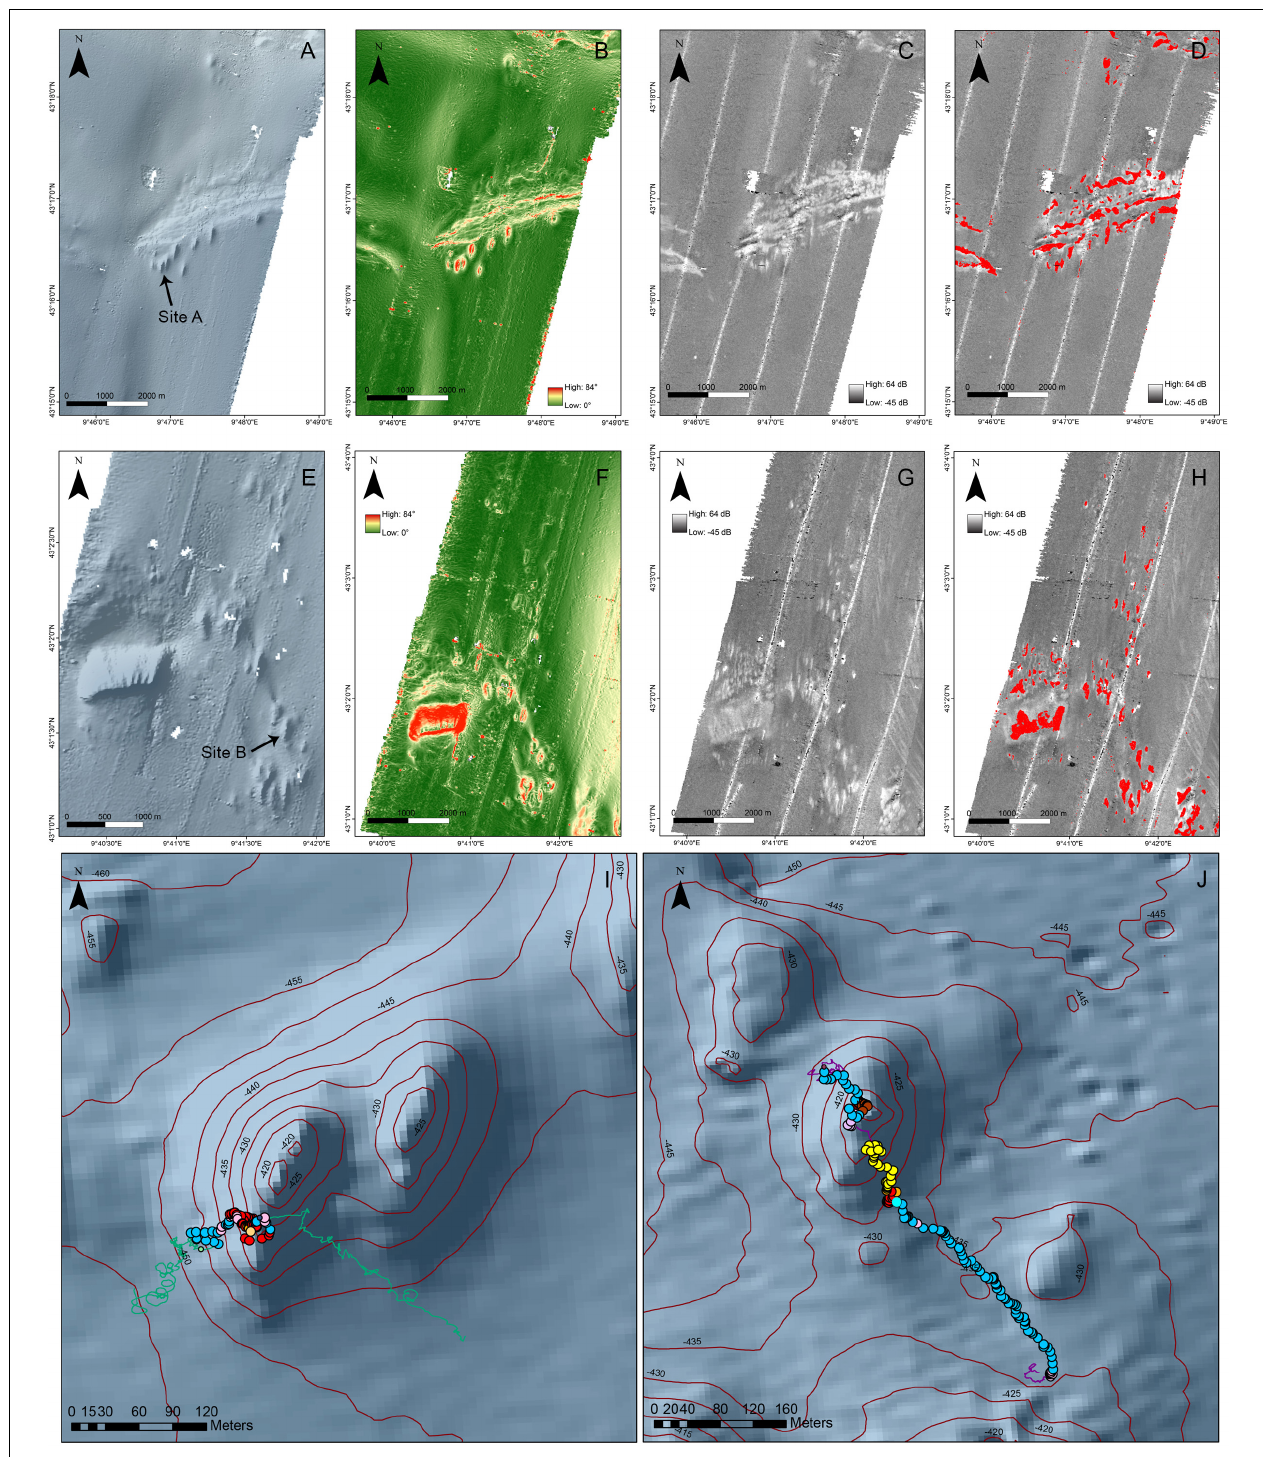
FIGURE 2 | Site A (A–D) and Site B (E–H) morphobathymetrical and backscatter data. Panels (A,E) represent the morphobathymetric map of the two coral mound areas; (B,F) slope map of the study areas, calculated from the digital terrain model (DTM), clearly showing the difference between the side slope of the coral mounds reaching a maximum value of 39 ◦ and the regional surrounding slope about 1 ◦ –8 ◦ ; (C,G) backscatter photomosaic of the surveyed area and (D,H) automatic selection of all features with backscatter intensity > 15 dB. (I,J) Habitat mapping performed on Site A remotely operated vehicle (ROV) survey and Site B, respectively; blue dots represent muddy sediments, red dots show living Madrepora oculata , yellow dots indicate the presence of coral rubble, and pink dots refer to cold-water coral (CWC) occurrences (e.g., living M. oculata and Desmophyllum pertusum ).